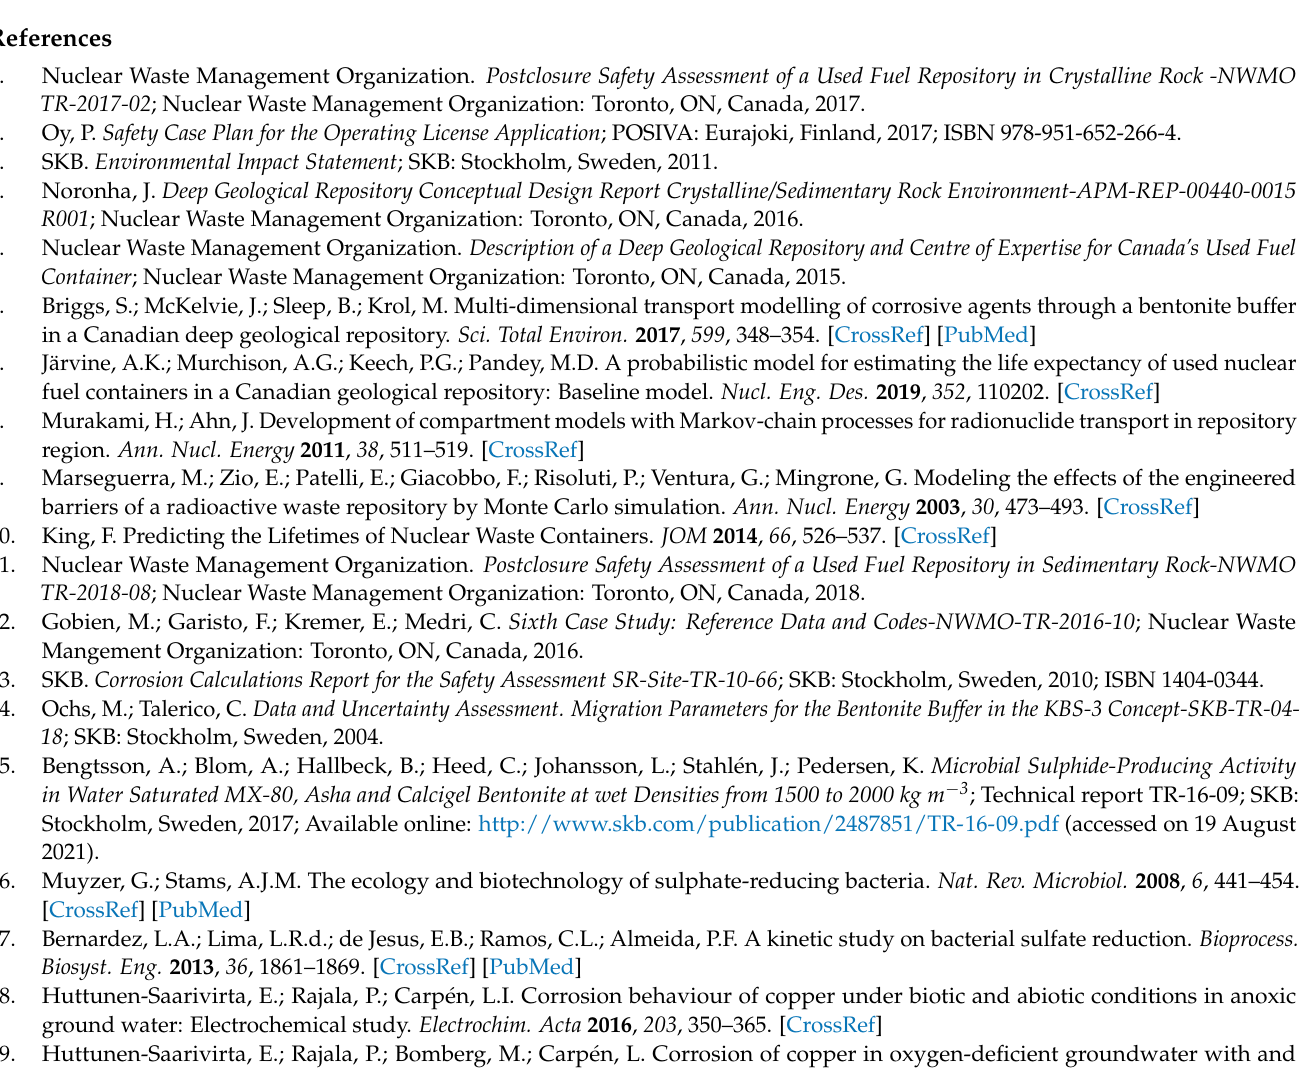
Figure A4. Profile of concentration at steady state for Scenario B.